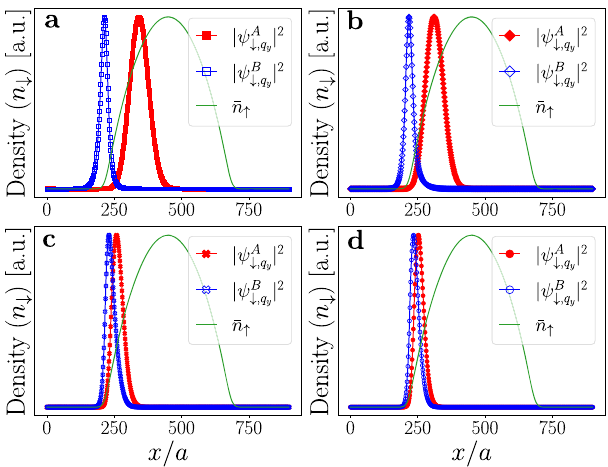
# Fig. 7 Landau levels density distributions for the ↓ atoms. Density of the ↓ atoms corresponding to the four markers indicated in Fig. 6. The A and B components of the eigenvectors of ^ H eff are denoted by ψ l for l = A , B # # ; q y respectively. Their respective points in the spectrum have the following coordinates ( q y a , E ): ( a ) (0.038, 0.0009), ( b ) (0.050, 0.0039), ( c ) (0.091, 0.0390), ( d ) (0.111, 0.0617).